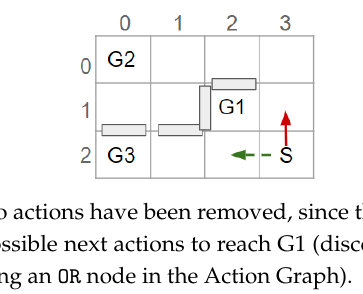
Figure 13. Example of a 3 goal environment, in which WCD (and thus ACD) cannot be reduced to